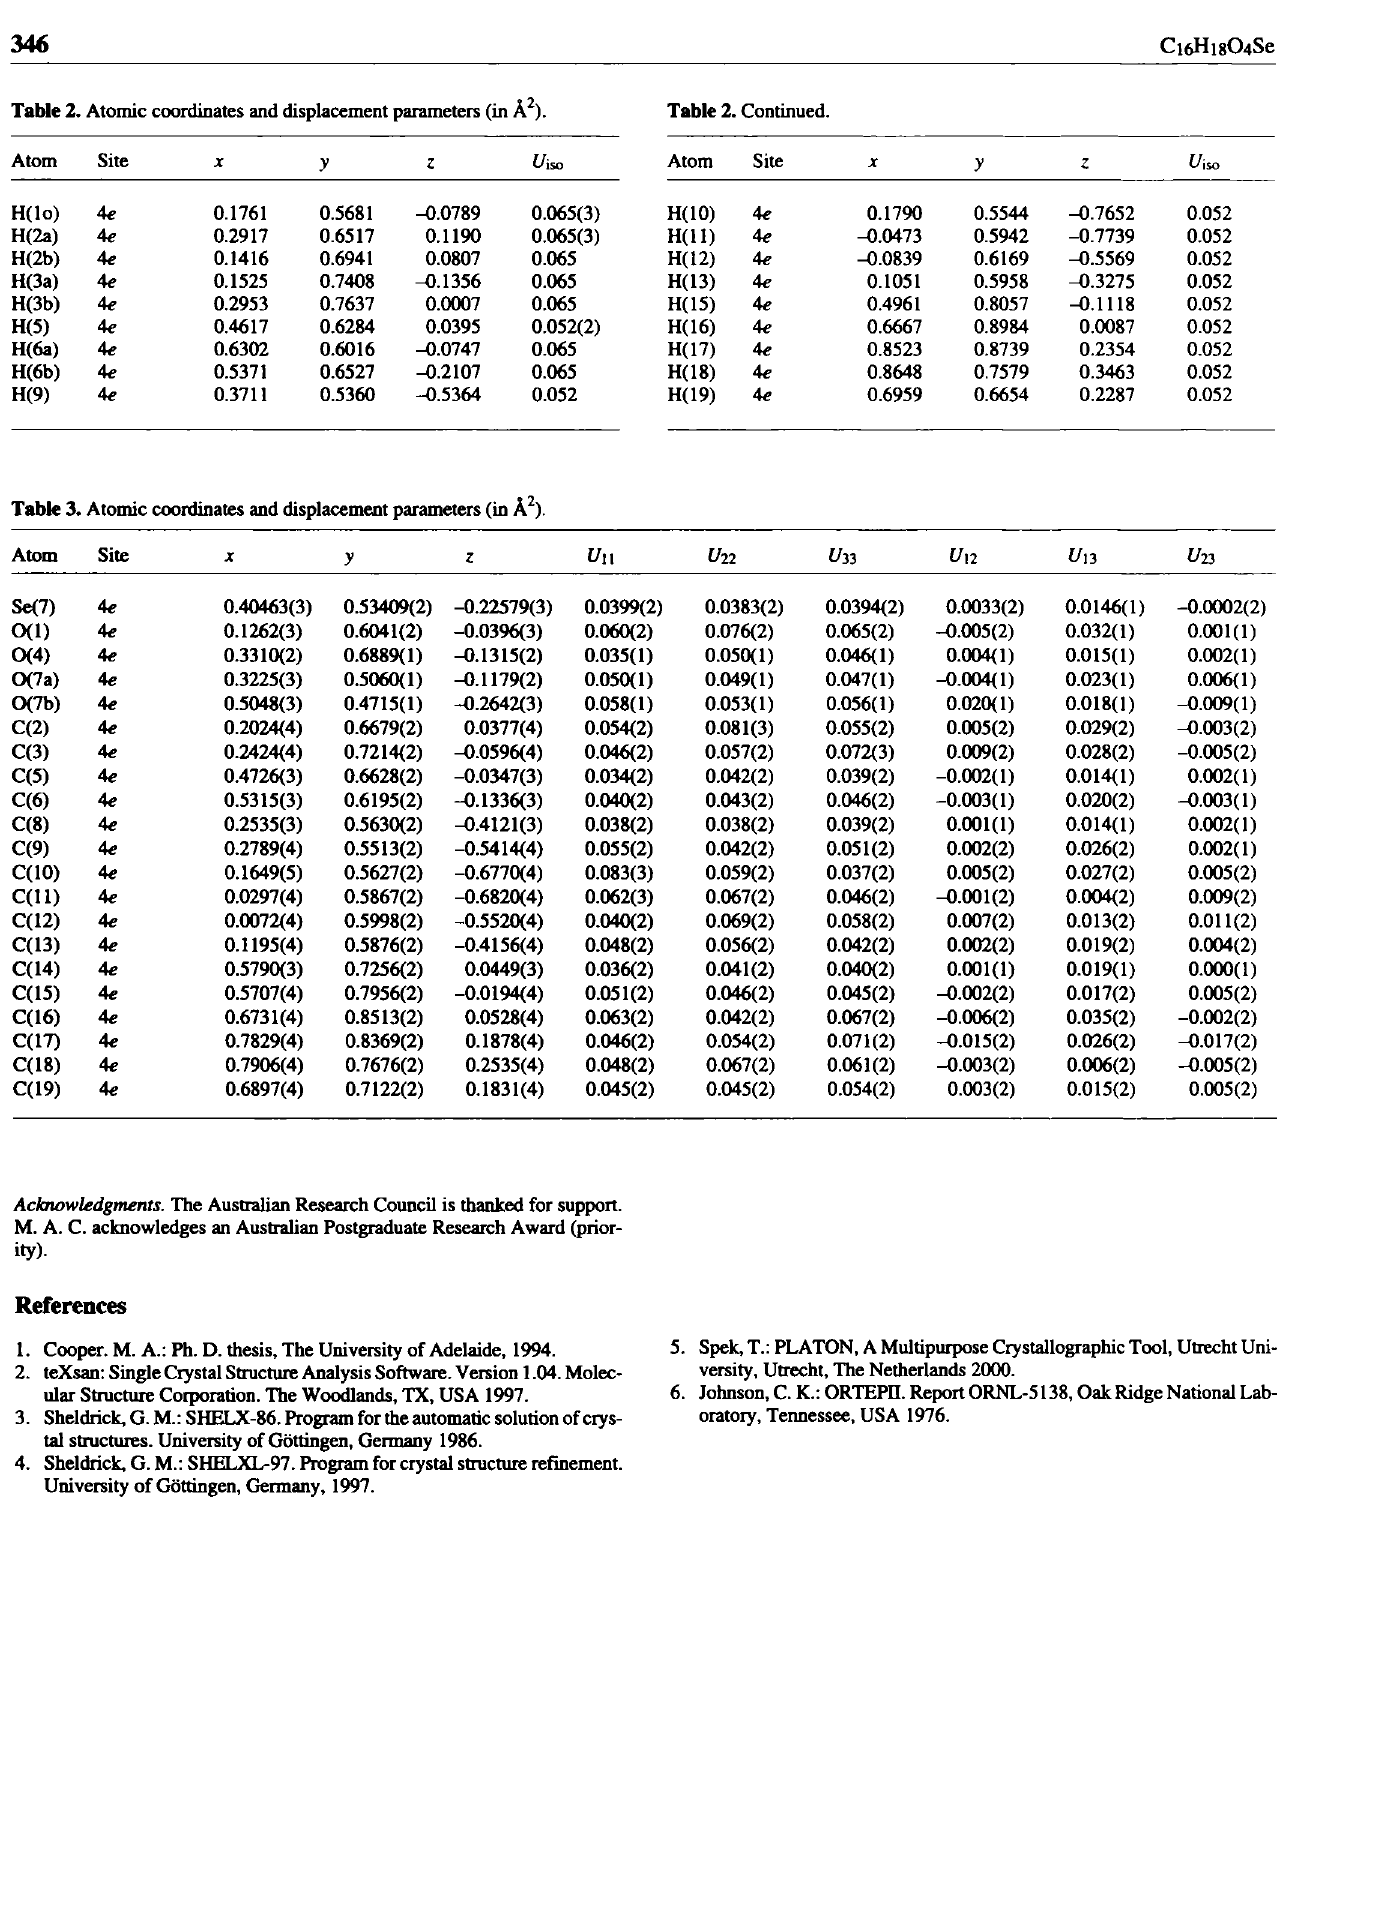
Table 2. Atomic coordinates and displacement parameters (in Â 2 ).